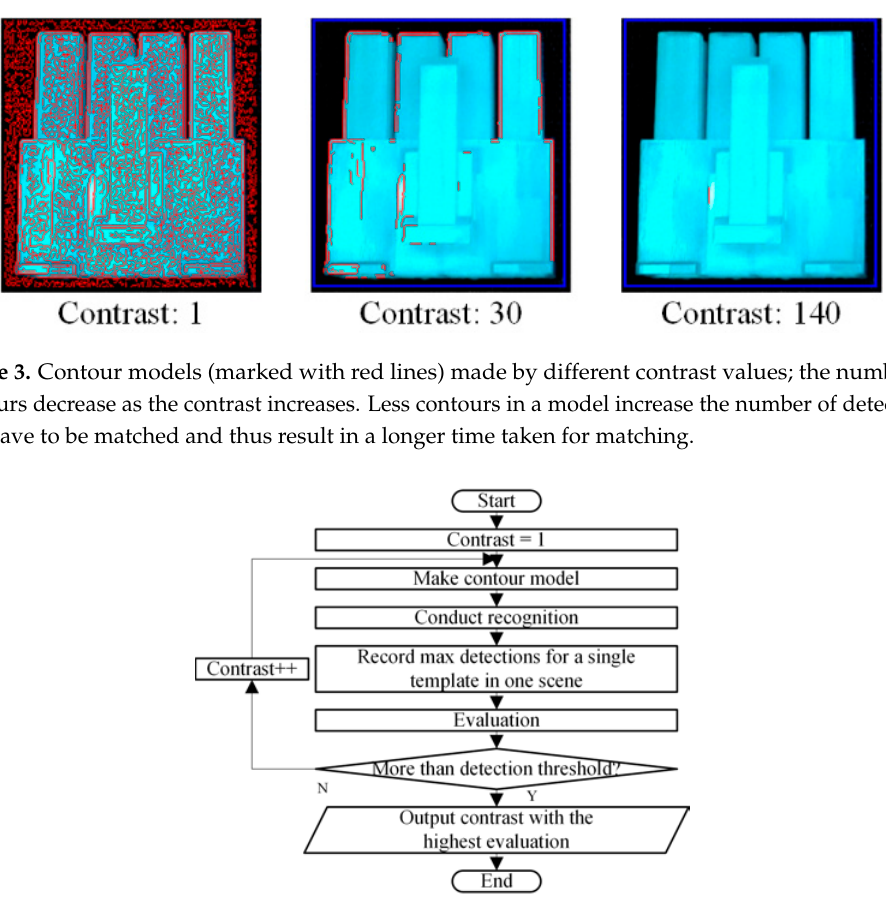
Figure 4. Contour models (marked with red lines) made by different contrast values, the number of contours decrease as the contrast increases. Less contours in a model increase the number of detections that should be matched and thus result in a longer time taken for matching. Algorithm proposed for contrast value design of the chosen recognition algorithm [HALCON (an image processing library of MVTec Company) shape-based matching].